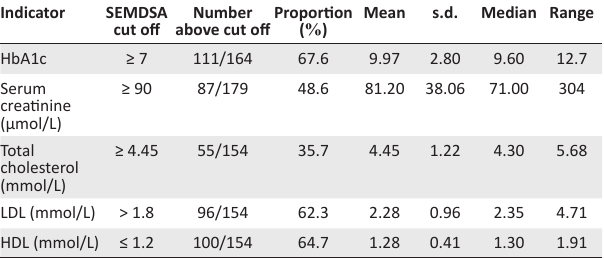
TABLE 5: Adequacy of diabetes control according to Society for Endocrinology Metabolism and Diabetes South Africa 2017. Indicator SEMDSA cut off